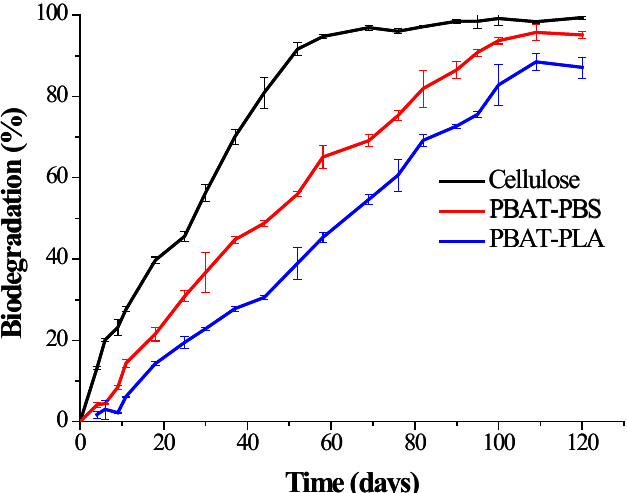
Figure 1. The biodegradation behavior of the PBAT–PLA and PBAT–PBS blends and cellulose (positive reference) under industrial composting conditions.